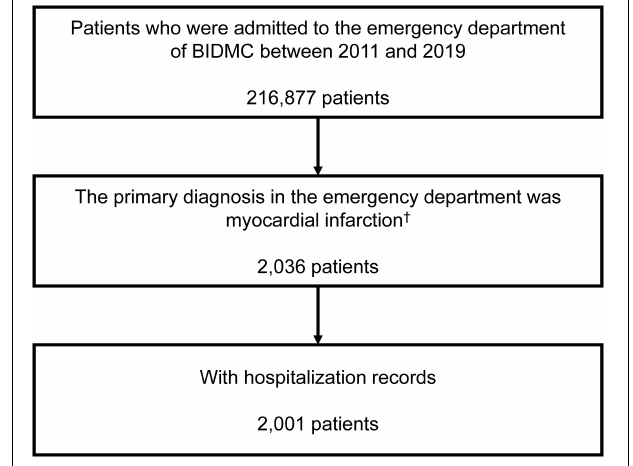
FIGURE 1 | Inclusion of the study population. † The first emergency department admission if a patient had more than one emergency department admission. BIDMC, Beth Israel Deaconess Medical